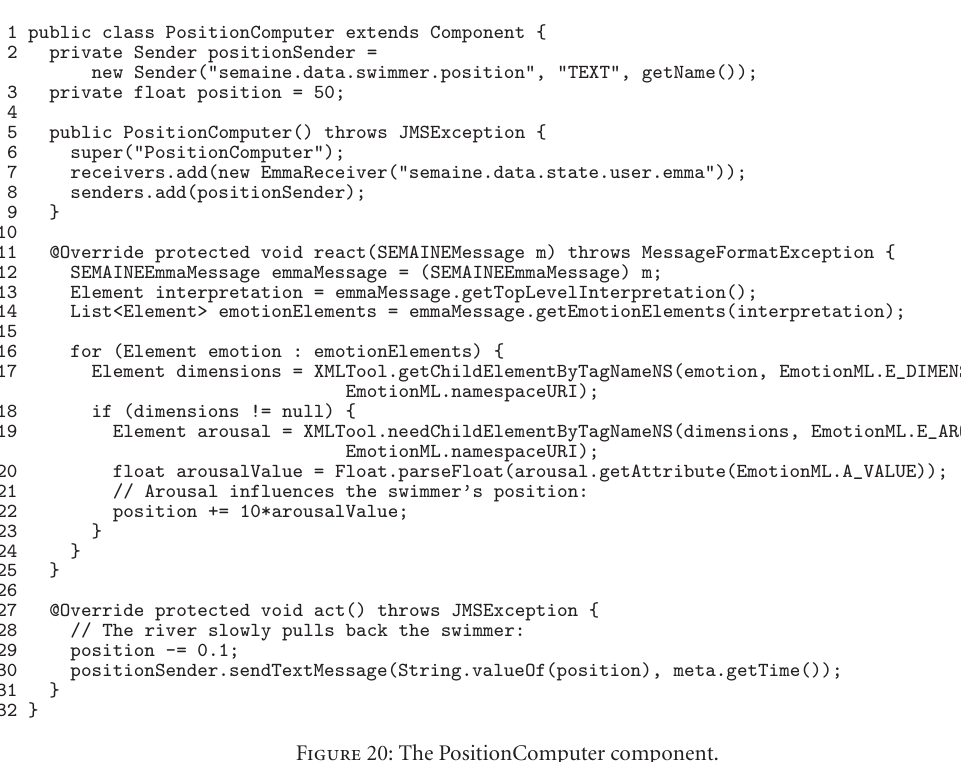
Figure 20: The PositionComputer component.